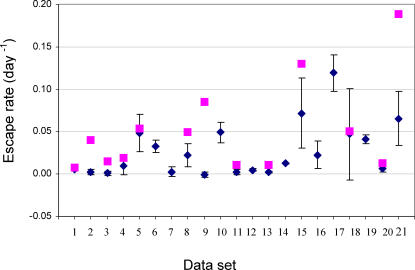
Escape Rate EstimatesBest (filled diamonds) and optimistic (filled squares) estimates of the rate of escape in each of the 21 datasets. Best estimates are shown ±1 standard error.